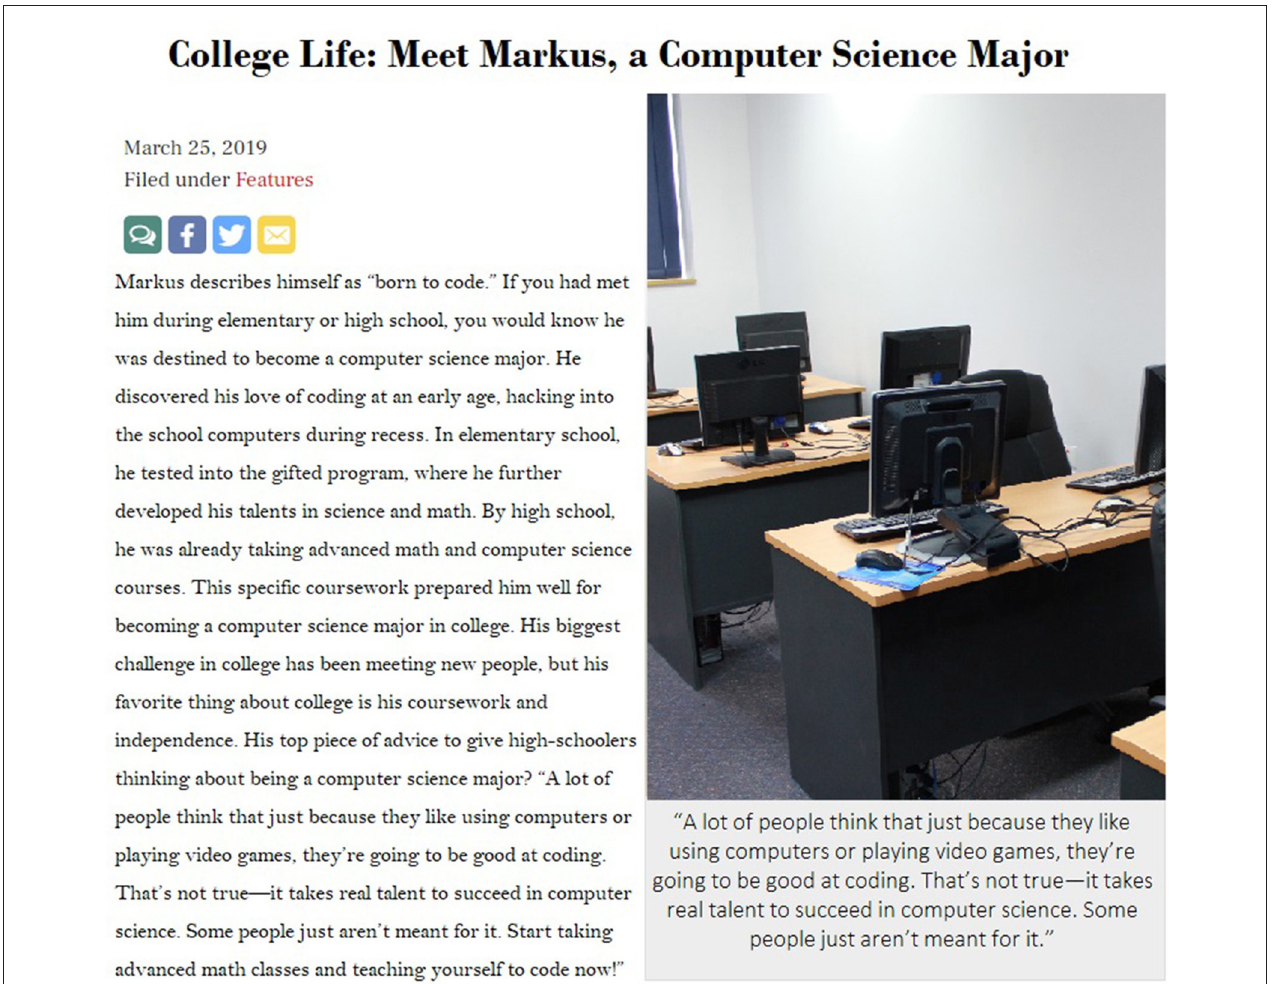
FIGURE 1 | Genius experimental condition